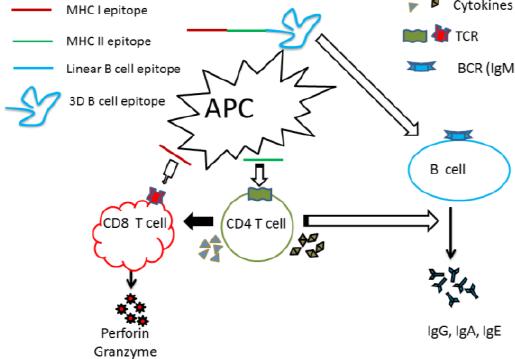
Figure 1. Central role of CD4 + T cells in peptide vaccines. Vaccine-induced immune response to control microbial pathogens may involve cytotoxic CD8 + T cell responses, helper CD4 + T cell responses, or antibody (B cell) responses. T cells recognize linear epitopes presented by antigen presenting cells, whereas B cells are capable of